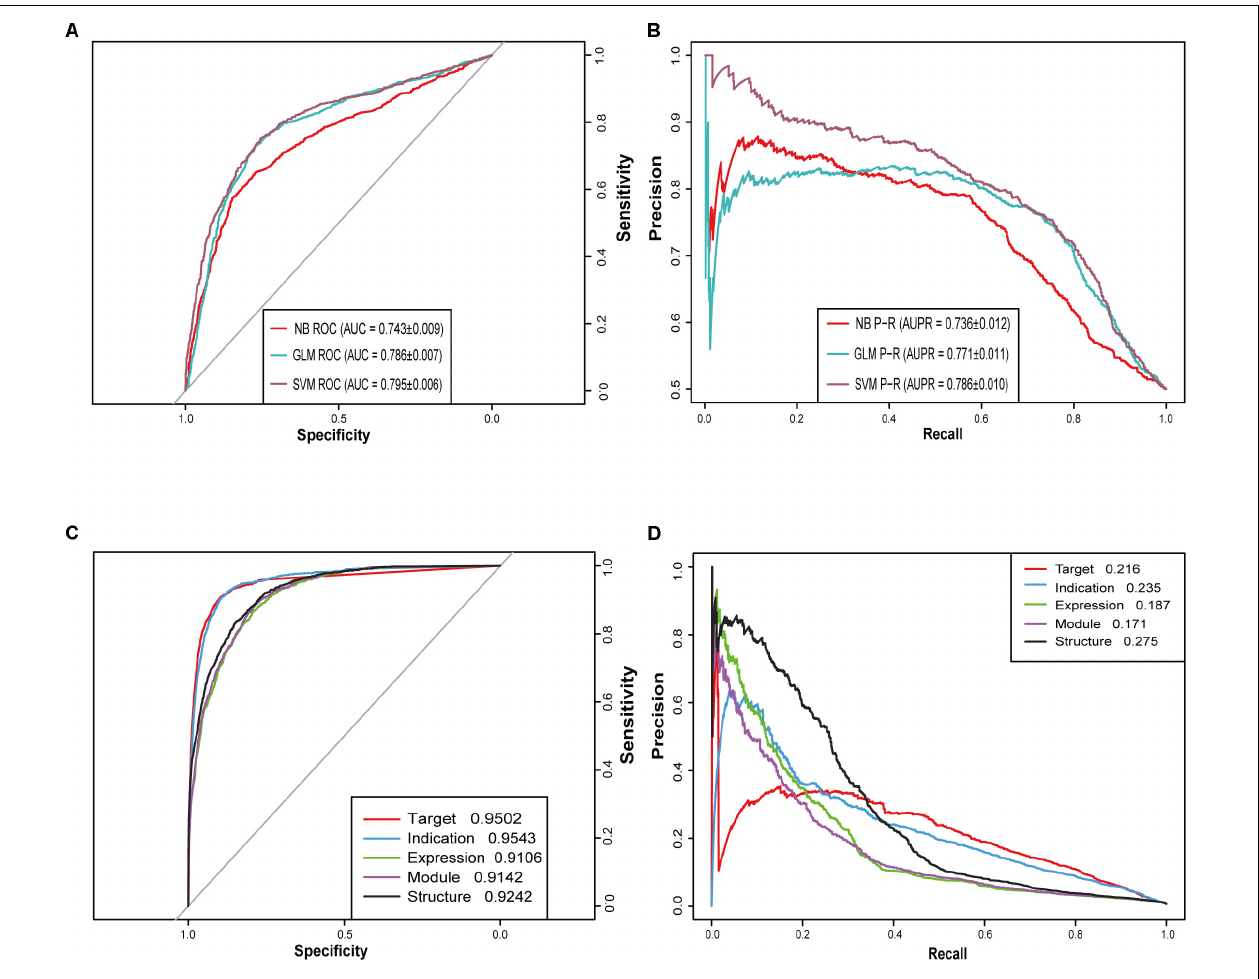
FIGURE 2 | Receiver operating characteristic (ROC) curves and precision-recall (PR) curves for different models. (A) ROC curves of three machine learning algorithms (SVM, GLM, and NB) when the ratio of positive and negative samples is 1:1. (B) PR curves of three machine learning algorithms (SVM, GLM, and NB) when the ratio of positive and negative samples is 1:1. (C) ROC curves of five similarity-based NRM models. (D) PR curves of five similarity-based NRM